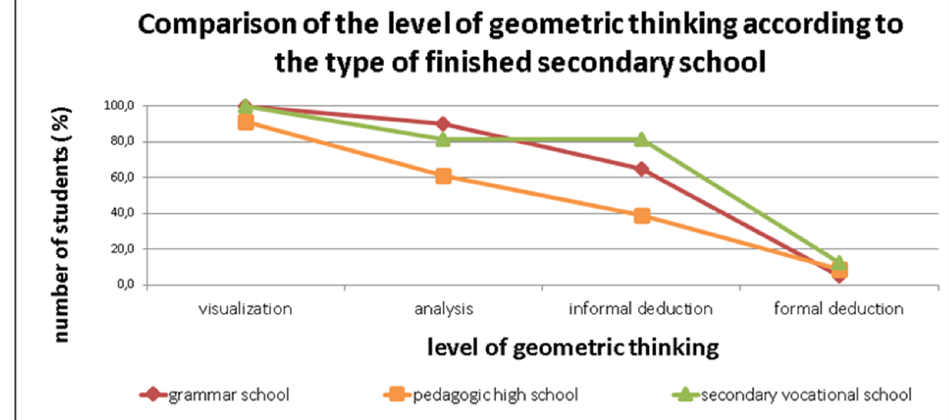
Figure 3. Comparison of the level of geometric thinking.